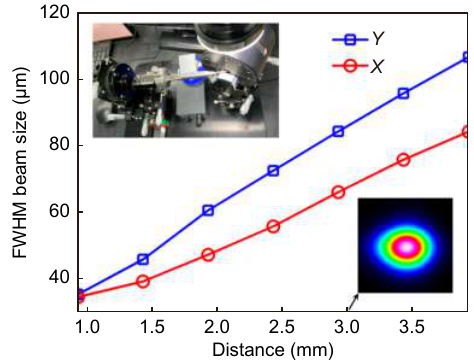
Fig. 5 | Catheter FWHM beam size at different imaging depth. X : horizontal direction, Y : vertical direction. Inset: beam profile at 2-mm position (right bottom); beam size measurement setup (left